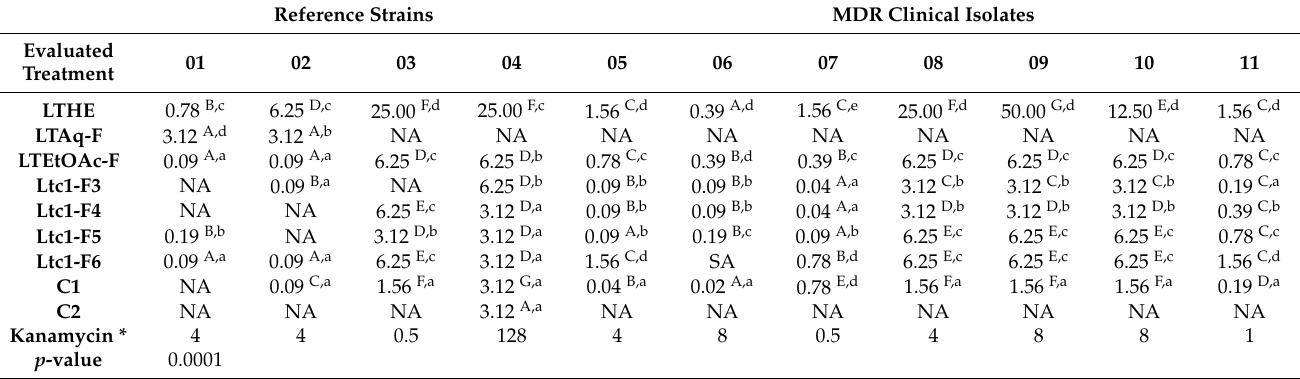
Table 4. Minimal bactericidal concentrations of L. tridentata against evaluated bacteria